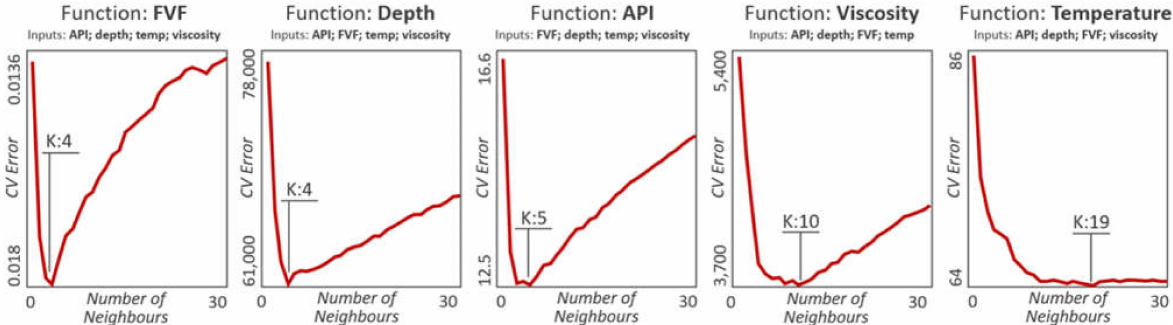
Figure 16. KNN cross-validation (CV) error curves for each variable (API, depth, FVF, temperature, viscosity) in five-dimensional space.